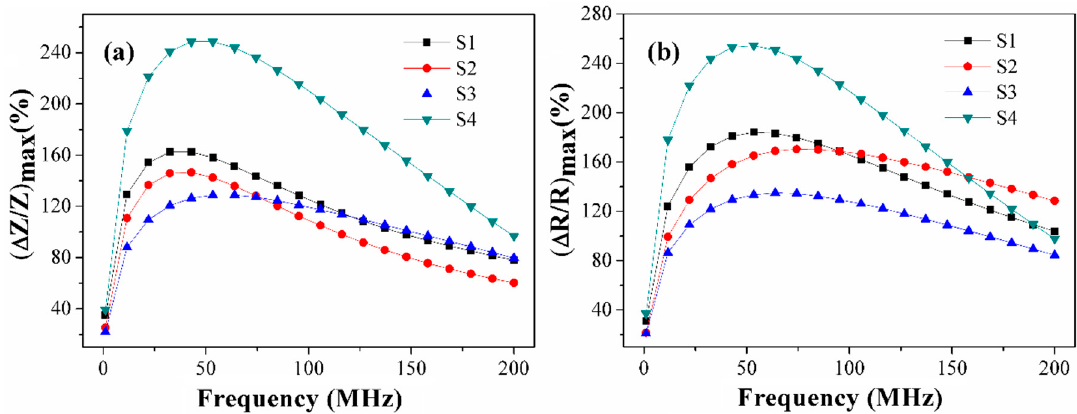
Figure 7. Frequency dependence of the maximal MI ratio for the ( a ) total impedance and ( b ) its real part for Co 75 Fe 10 Ni 2 Si 8 B 5 meander samples.